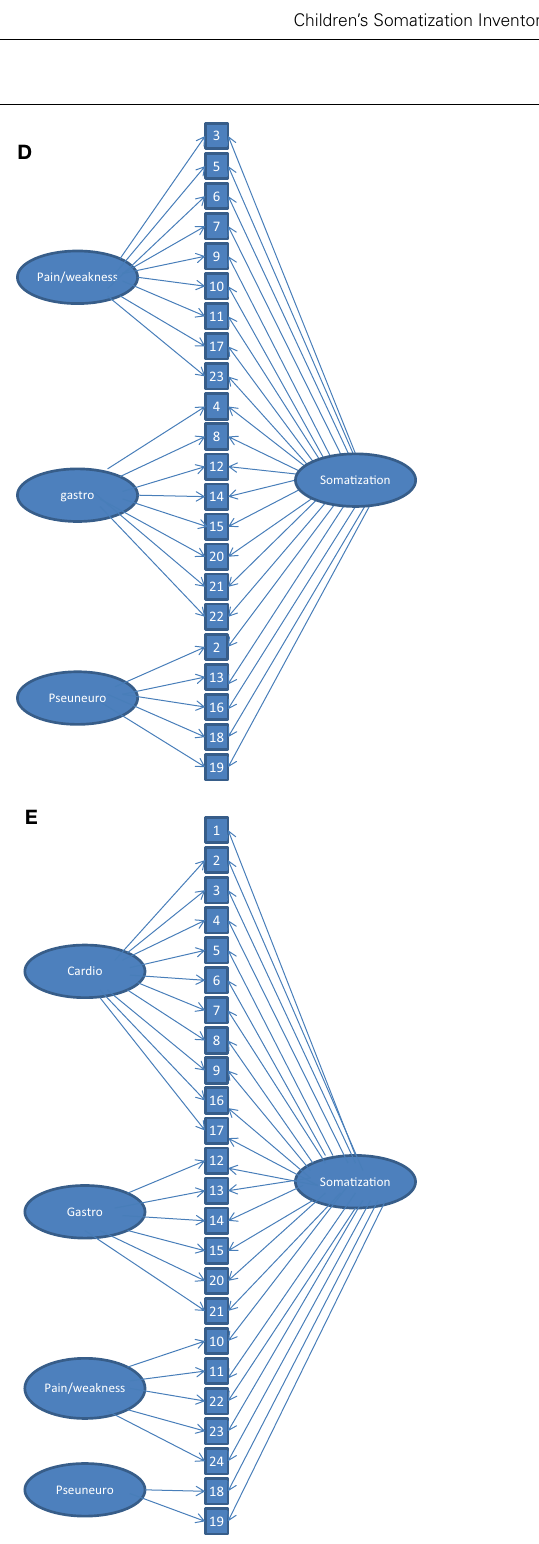
FIGURE 1 | Five factor models tested with CFA . (A) unidimensional model (14). (B) three-correlated factor model (3, 13). Item 16 (“heart beating”) was considered as part of the pseudoneurological symptoms (3). (C) four- correlated factor model (11, 12). Item 1 (“headaches”) was not included as was proposed by the authors. (D) bifactor model with one general factor